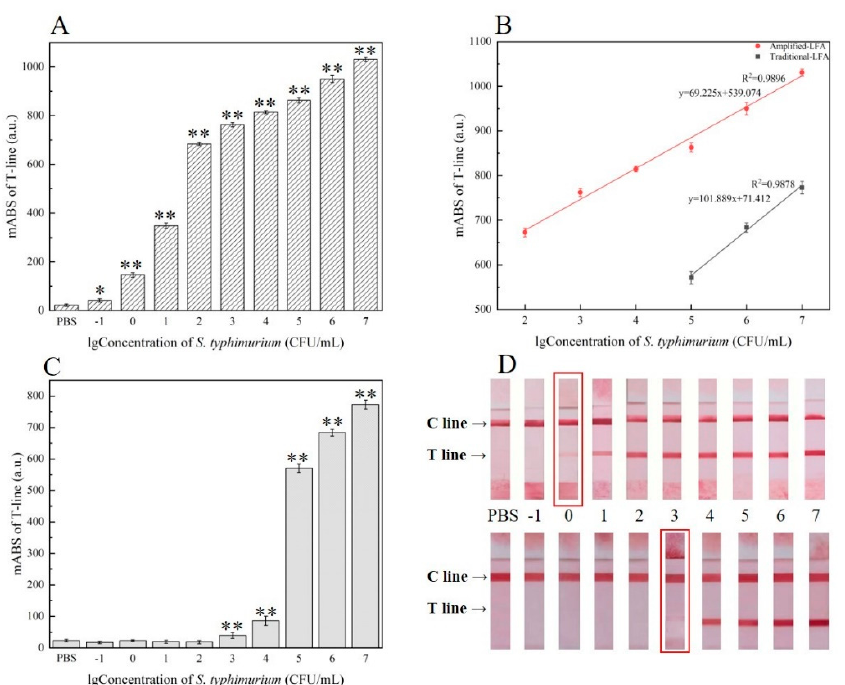
Figure 5. Analytical characteristics of the enhanced lateral flow assay and unenhanced lateral flow assay: Sensitivity of the enhanced lateral flow assay ( A ) and unenhanced lateral flow assay ( C ) when different S. Typhimurium concentration was applied; data represent mean ± SD ( n = 3, * p < 0.05, ** p < 0.01 vs. PBS group). Linear response of the two kinds of strips (enhanced and unenhanced) for S. Typhimurium detection ( B ); photographs of the enhanced detection (up) and unenhanced detection (down) for 8.6 × 10 − 1 –8.6 × 10 7 CFU/mL S. Typhimurium in PBS ( D ). Data represent mean ± SD ( n = 3). Error bars indicate the standard errors of three independent experiments.